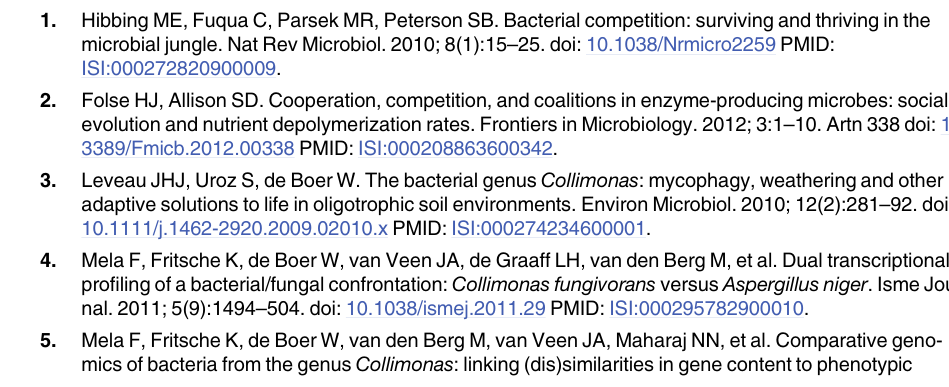
S3 Table. Primer that were developed for this study. Amplified gene, respective sequences of forward and reverse primers, annealing temperatures, and resulting amplicon sizes are